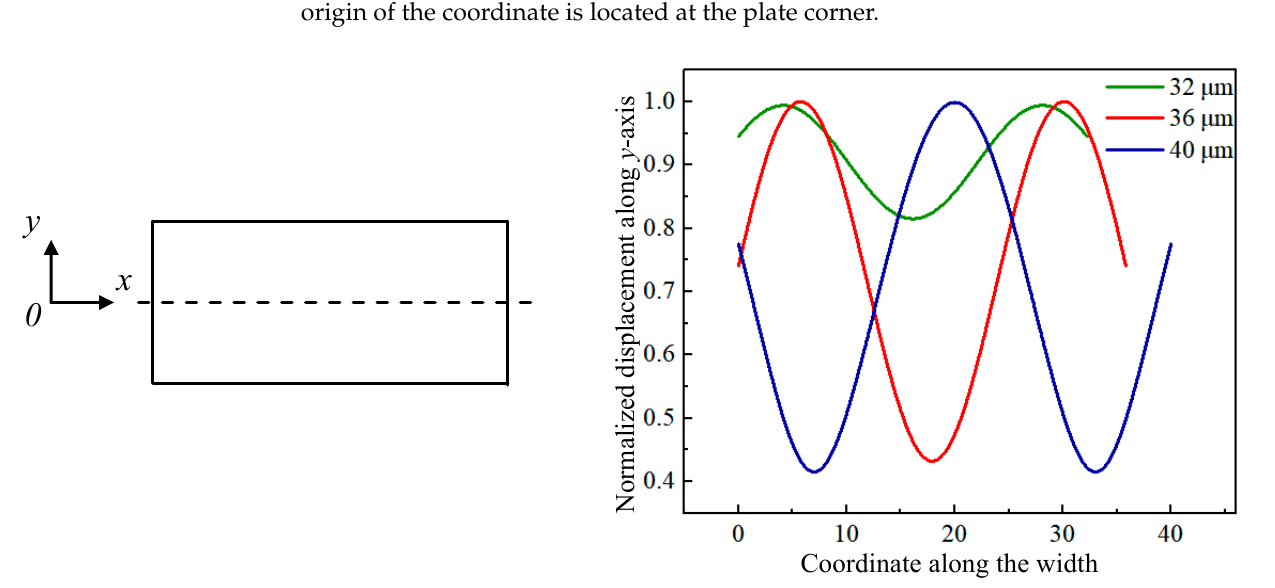
Figure 2. Displacement distribution along the x -axis for the 1st WEM of the 13.5 µ m-wide resonator with lengths from 32 µ m to 40 µ m.